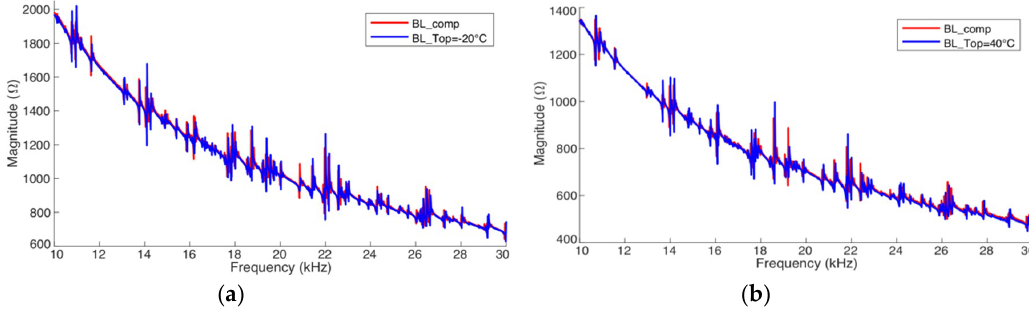
Figure 19. Complete compensation for pipe-2/PZT-2 (Experiment): ( a ) from −40 °C to −20 °C and ( b ) from +80 °C to +40 °C.